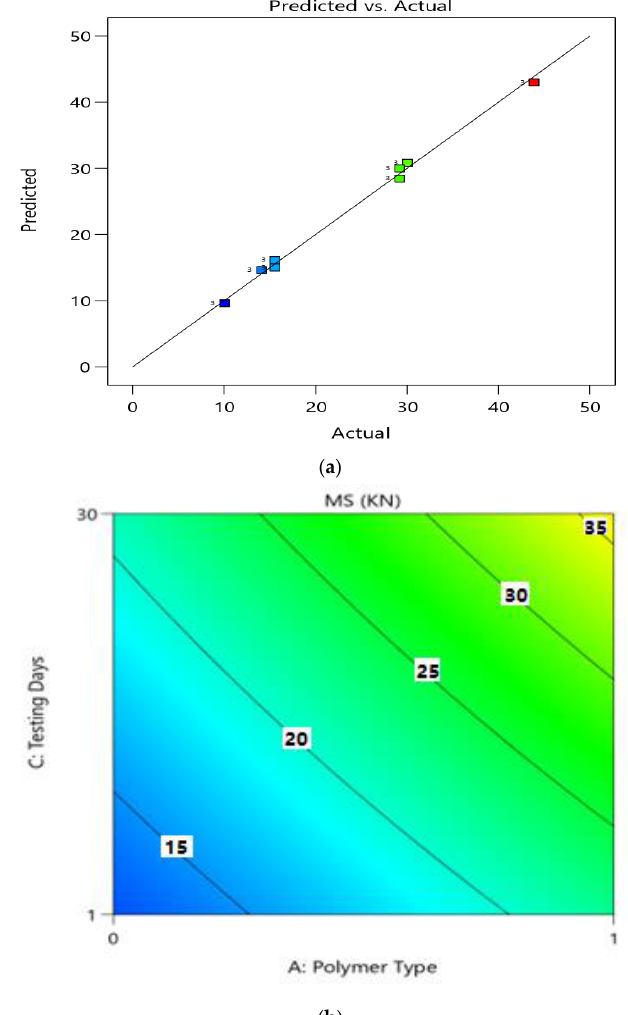
Figure 10. Predicted vs. actual plot ( a ) for MS (kN); ( b ) Contour plot (2D) between the MS (kN) and Factors.